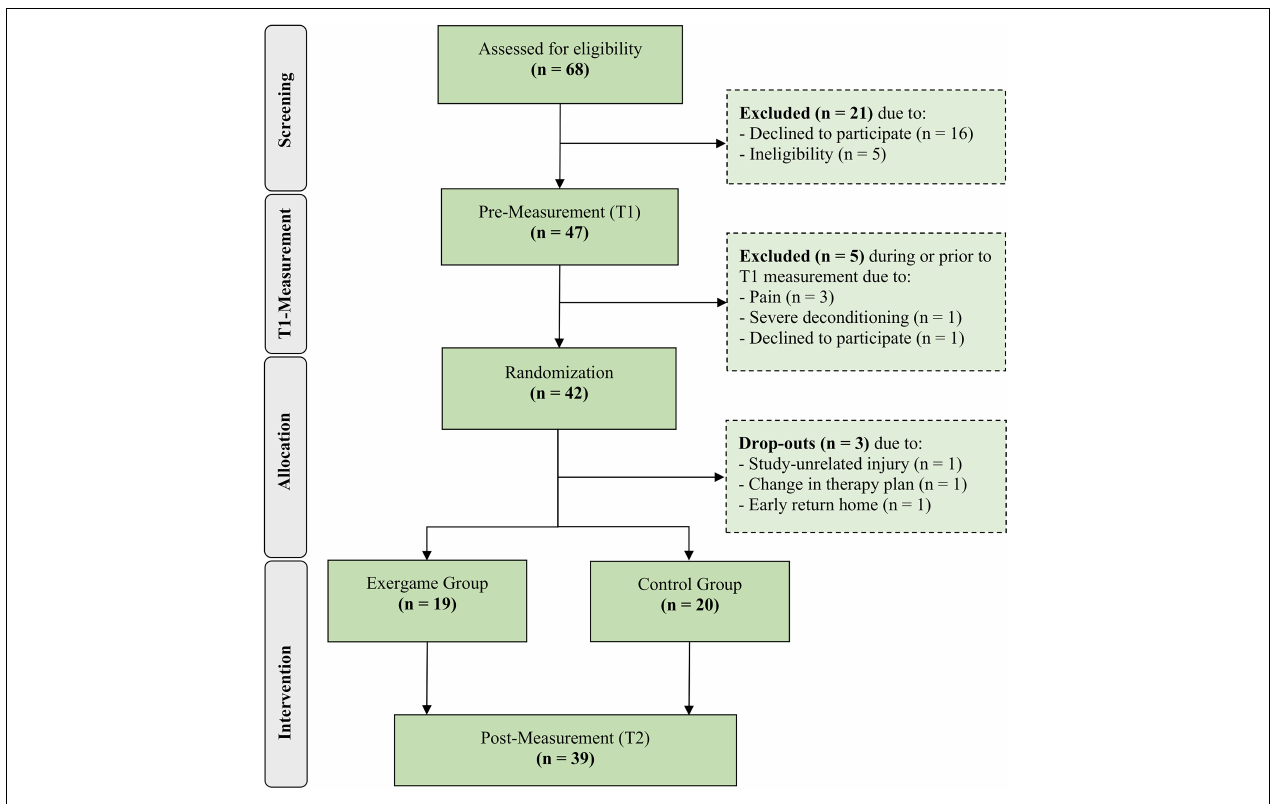
FIGURE 1 | Flow diagram of screening and group allocation (based on Eldridge et al.,